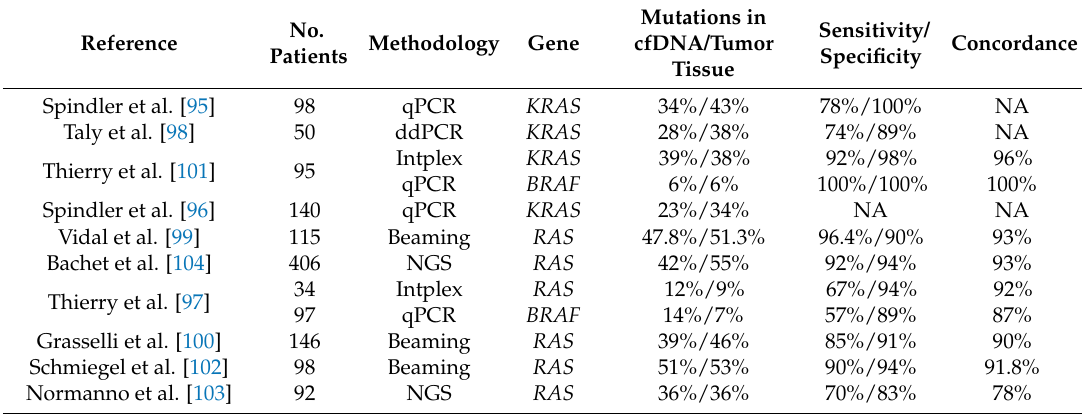
Table 1. Concordance between tumor tissue and cell-free DNA (cfDNA) for RAS , and BRAF mutations in metastatic CRC